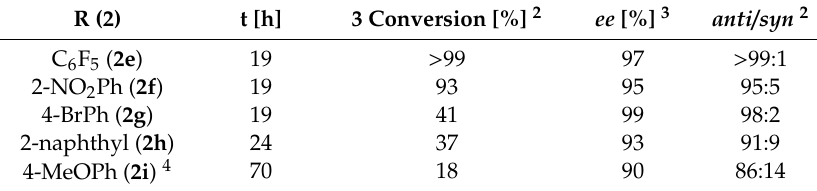
Table 2. MeOH / H 2 O-based protocol applied to di ff erent aromatic aldehydes 2 1